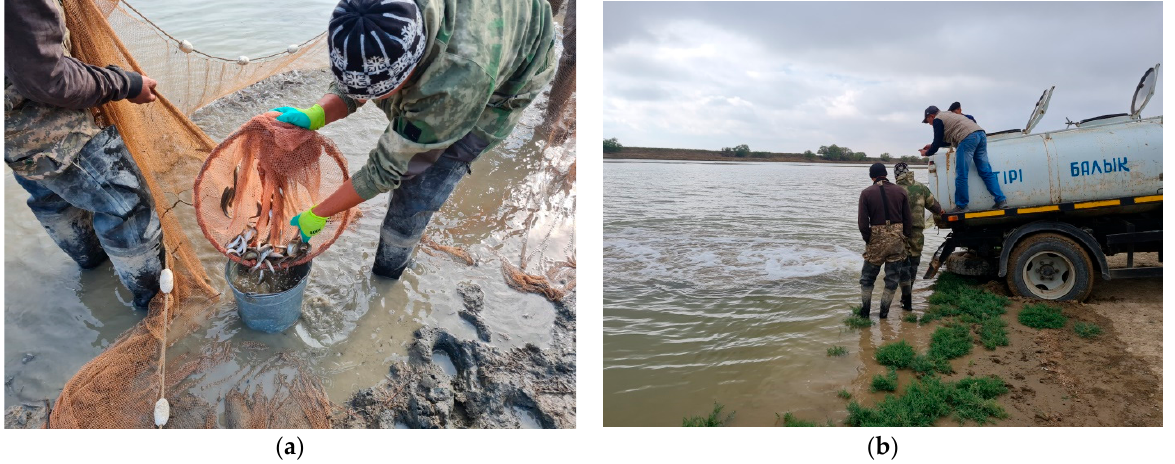
Figure 3. Juvenile barbels rescue in rice checks: ( a ) harvest of barbel from paddy checks; ( b ) transport of rescued barbel juveniles.